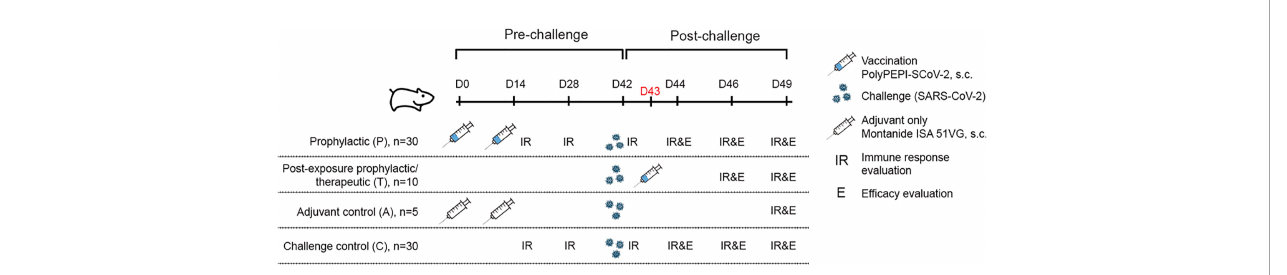
FIGURE 1 Study outline and overview of experimental groups. 9-10 week old Syrian hamsters (n=75) were divided into 4 cohorts. Hamsters were immunized with PolyPEPI-SCoV-2 subcutaneously on Day 0 (D0) and D14 (prophylactic setting, P) or as a PEP treatment (T) on D43, one day after challenge with SARS- CoV-2. As controls, hamsters were injected with adjuvant only (A) or were left untreated (C). Where indicated, (A, C) controls were combined as Controls (C):( A+C). Hamsters were challenged with 10 2 TCID50 SARS-CoV-2 on D42 and 5 animals were sacri fi ced in each group for immune response (T cell response and antibody, IR) and ef fi cacy evaluation (body weight, virology and pathology, (E) at study days (D) indicated on the fi